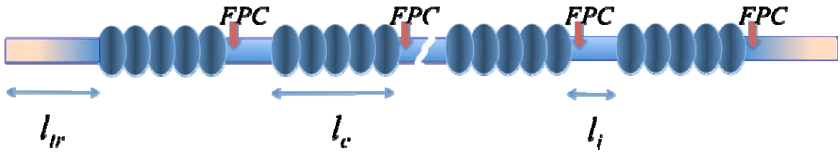
FIG. 1. (Color) A schematic of a high-current, multicavity SRF linac, with fundamental power couplers (FPCs). It comprises N five- cell cavities linked by interconnects, and terminated by cryogenic-to-room-temperature